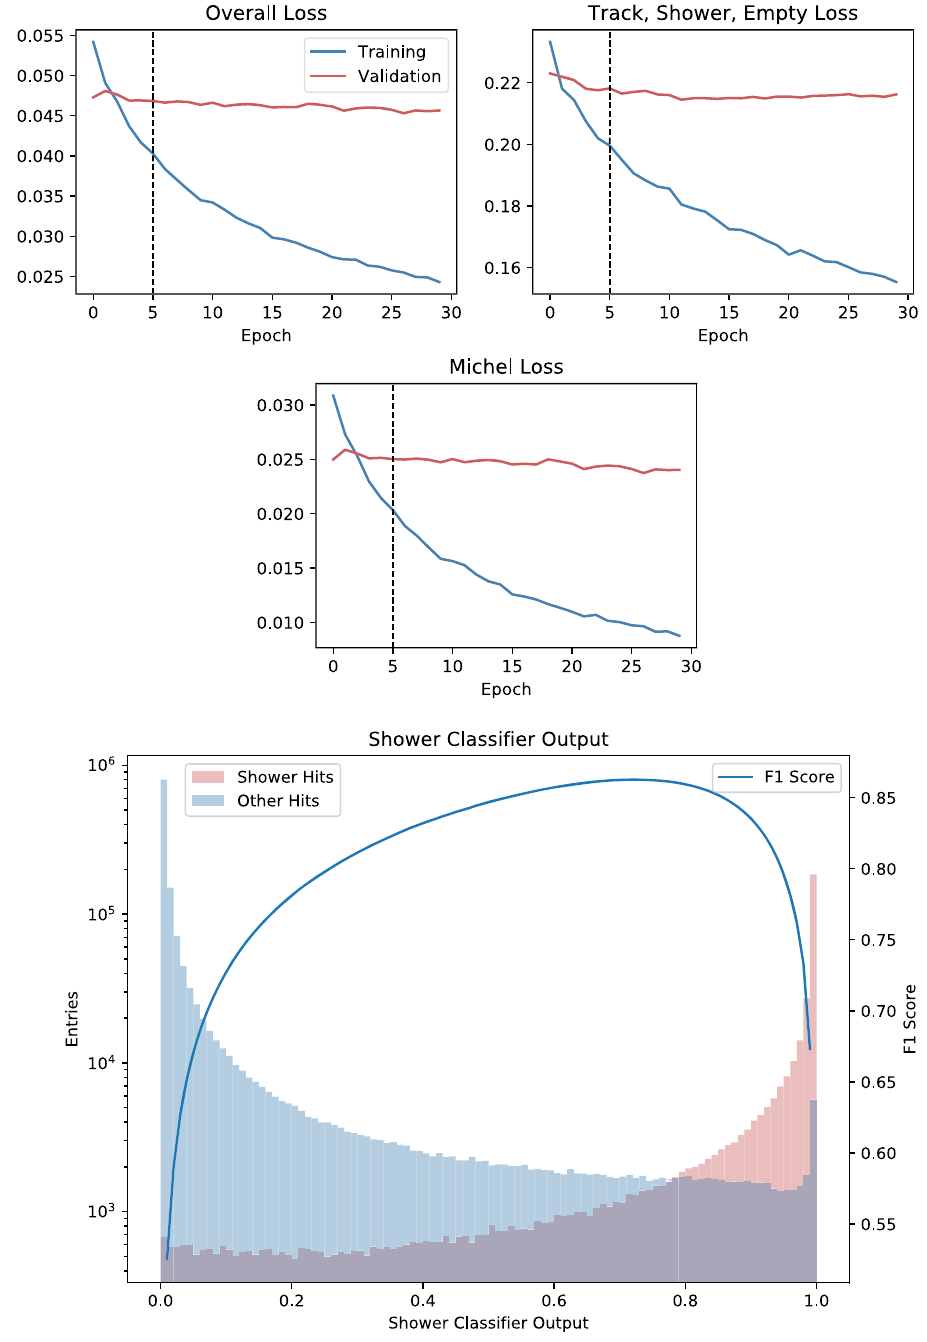
Fig. 4 Evolution of the training and validation losses as a function of training epoch. The final weights of the network were taken from a checkpoint at the end of the fifth epoch, shown here as a vertical line. The overall loss; track, shower and empty loss; and Michel loss are shown in the top left, top right, and bottom left respectively. In calculating the overall loss, the track, shower and empty loss is weighted by 0.1 to be consistent with the smaller size of the Michel sample